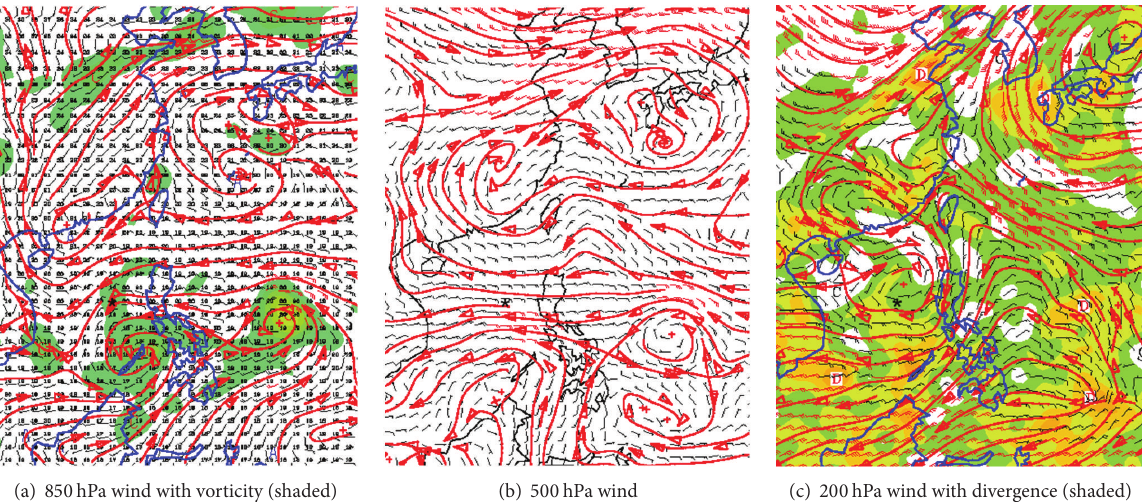
Figure 2: Upper-air analysis from JMA global model. The asterisk shows the location of the severe turbulence event.